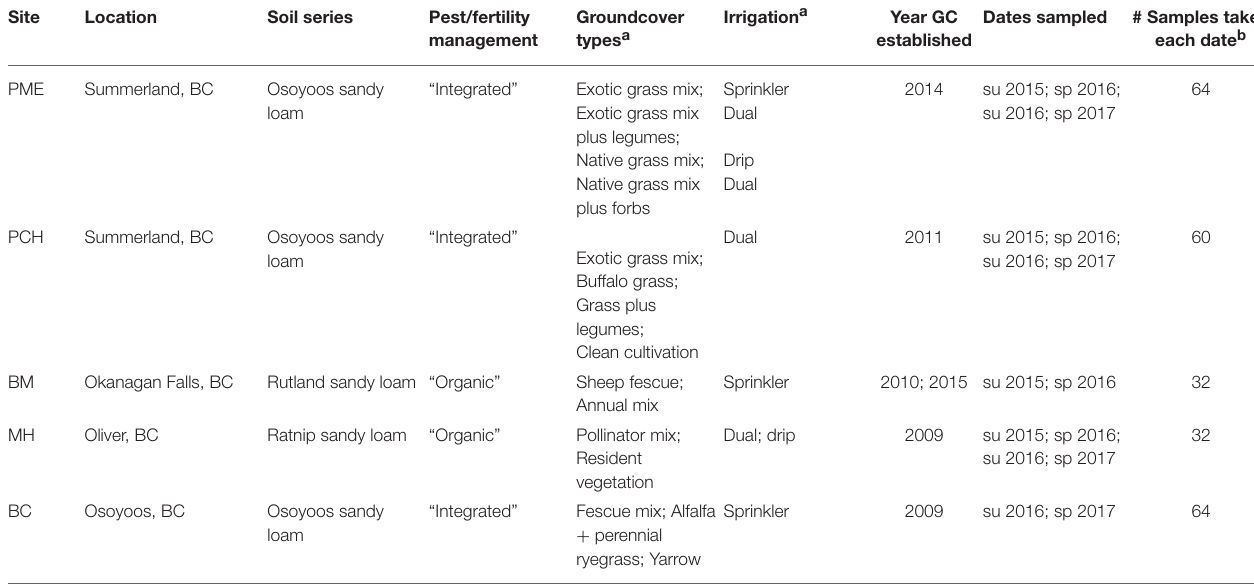
TABLE 1 | Characteristics of vineyard sites sampled during this